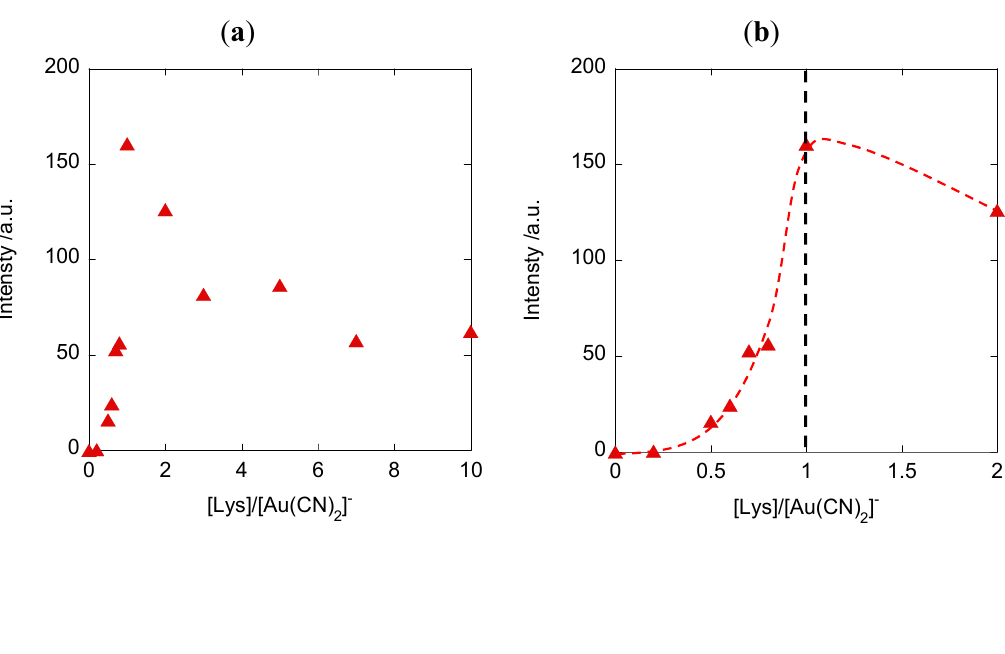
Figure 5. ( a , b ) Variations in the fluorescent intensity of 2 /[Au(CN)